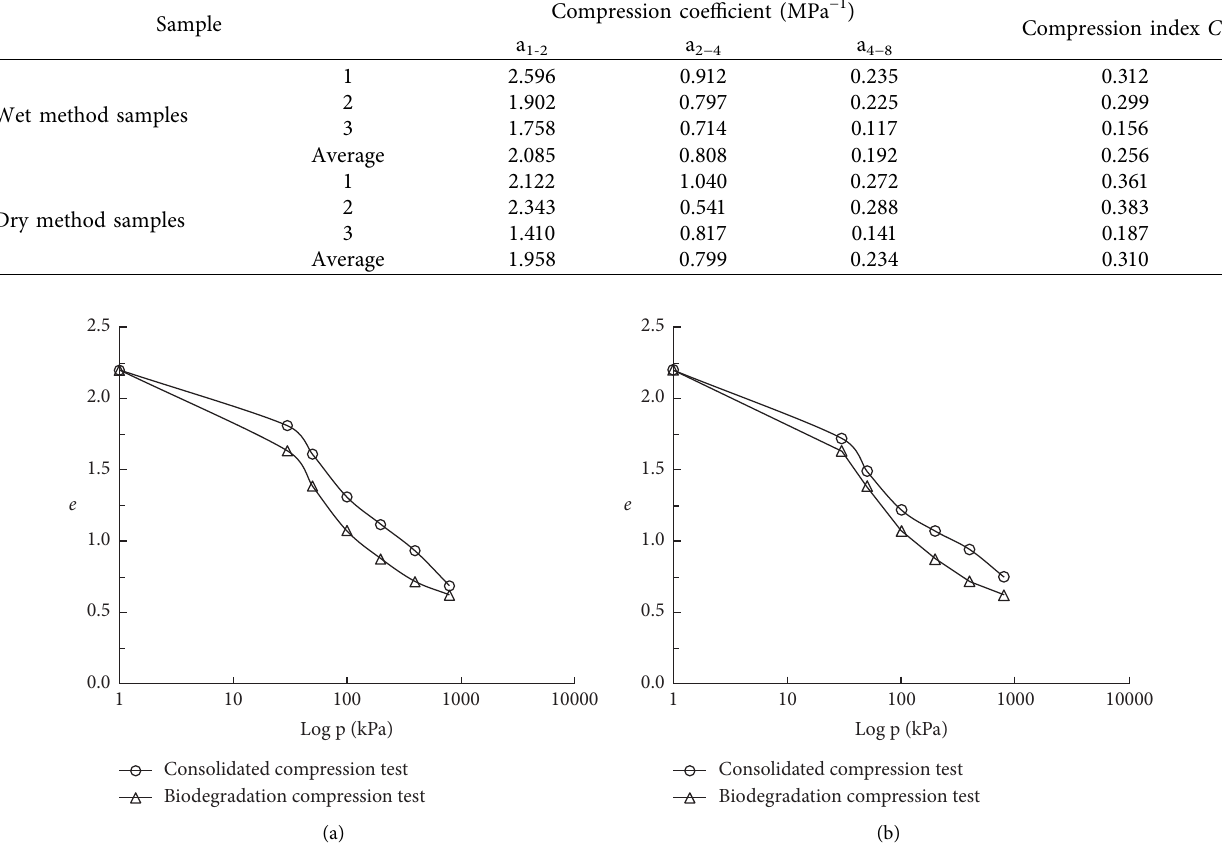
Table 11: Biodegradation compression parameters of different samples.